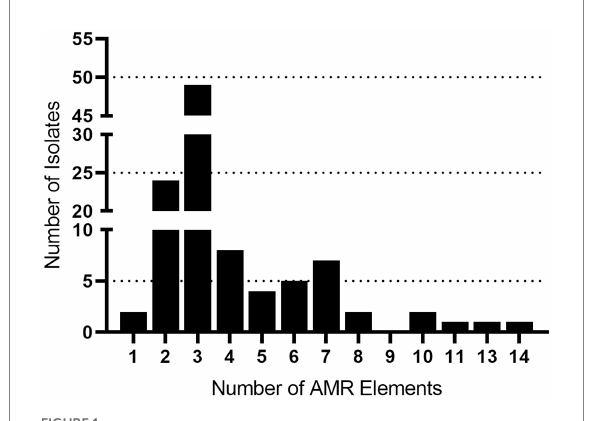
FIGURE 1 AMR gene frequency among Streptococcus suis isolates. The x axis indicates the number of AMR genes harbored by a single isolate. The y axis indicates the number of isolates identified harboring each number of AMR genes.